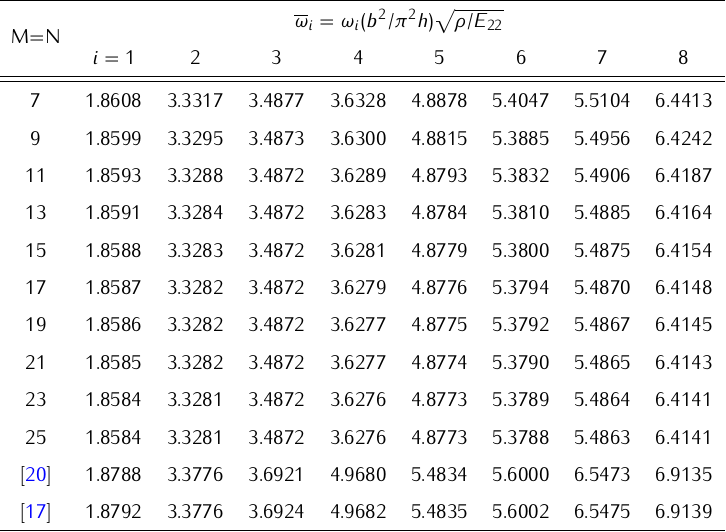
)p ρ/E ) of fully clamped moderately thick anisotropic plates i = ω i ( b 2 /π 2 h 22